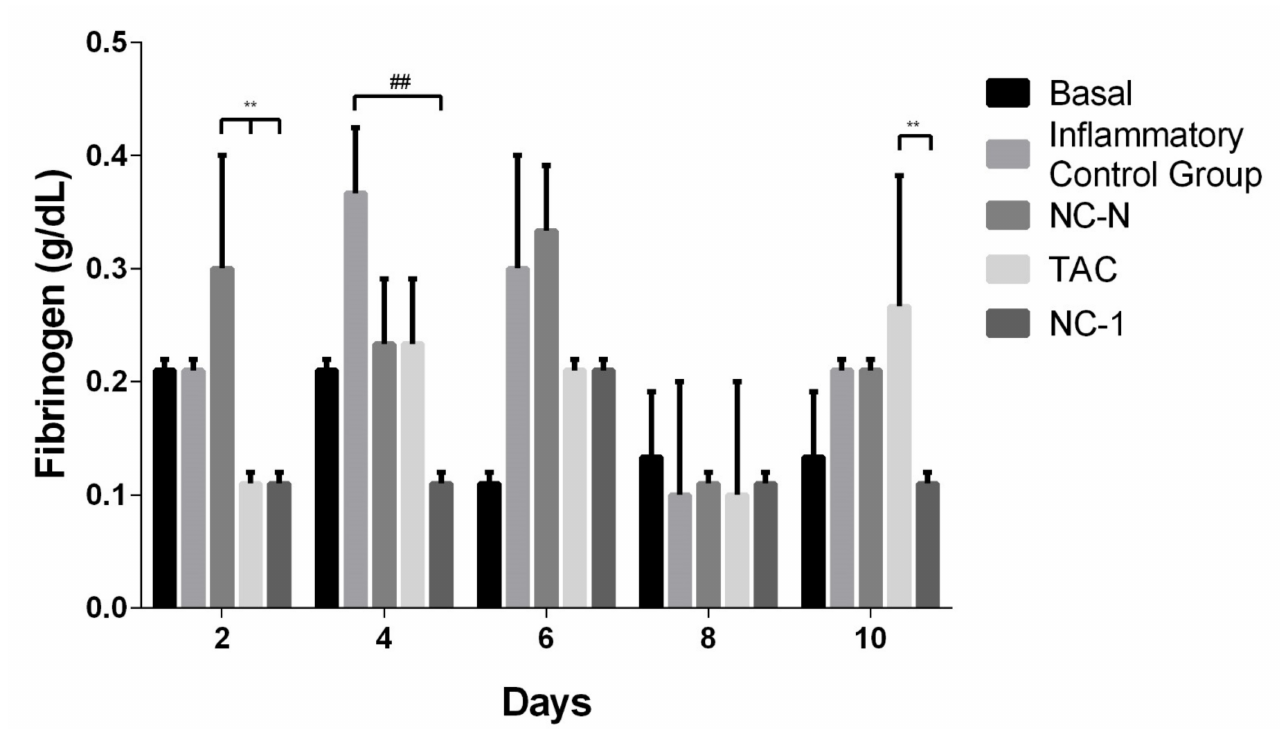
Figure 7. Effect of TAC, non-loaded, and TAC-loaded nanocapsules (NC-N and NC-1) on serum fibrinogen in TPA-induced male Balb/c mice. Statistical analysis performed on each group on days 2, 4, 6, 8, and 10 of treatment. ANOVA statistical test with Tukey post-test, with significance of **/## p < 0.01, when compared with the inflammatory control group (ICG) or between TAC, NC-N, and